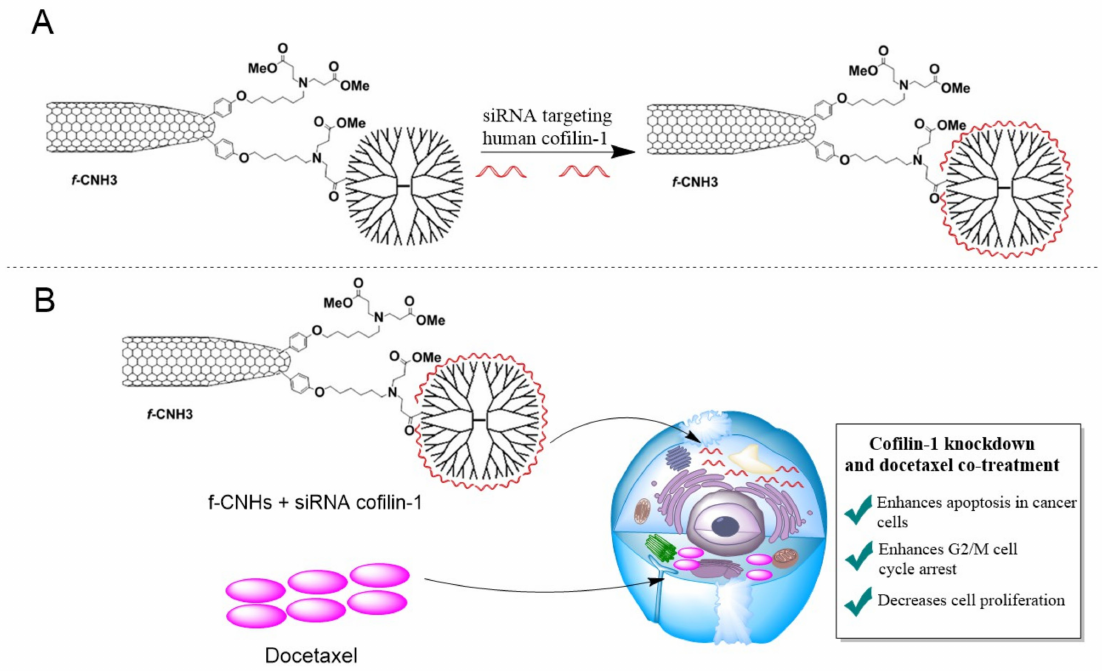
Figure 5. Schematic representation of an experiment involving the use of f-CNH3 hybrid nanovector. ( A ) Conjugation of f-CNH3 with siRNA targeted against human cofilin-1, a key protein in the regulation of cellular cytoskeleton. ( B ) Synergistic effects of siRNA against cofilin-1 and docetaxel on the LNCaP prostate cancer cell line. The f-CNH3-transported siRNA is released in the cell and inhibits cofilin-1 protein expression, leading to the “sensitization” of tumor cells to the effects of docetaxel treatment, resulting in widespread apoptosis, cell-cycle arrest at the G2/M phase, and subsequent inhibition of tumor cell proliferation. Adapted with the permission of